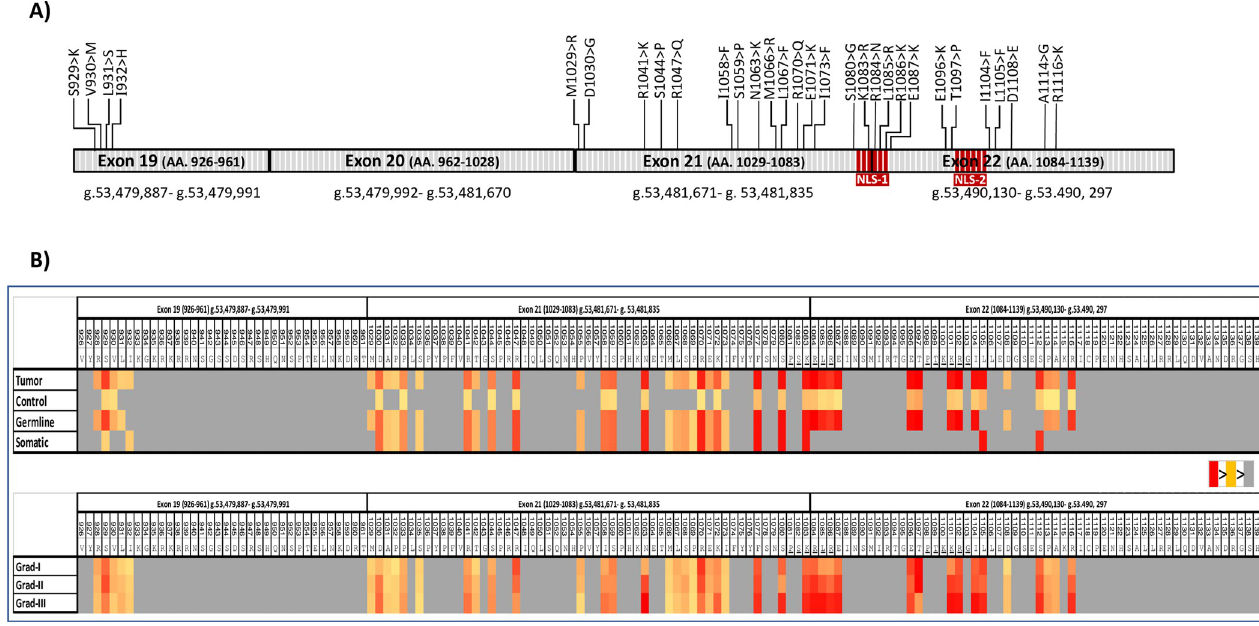
Fig 2. Association and hazard ratio analysis of various Rbl2 mutation. A) Correlation plot of various Rbl2 pocket mutations among each other as well as disease grad, histopathological types and Rbl2 transcript expression; B) Forest plot of OR calculated for various Rbl2 pocket domain mutations.